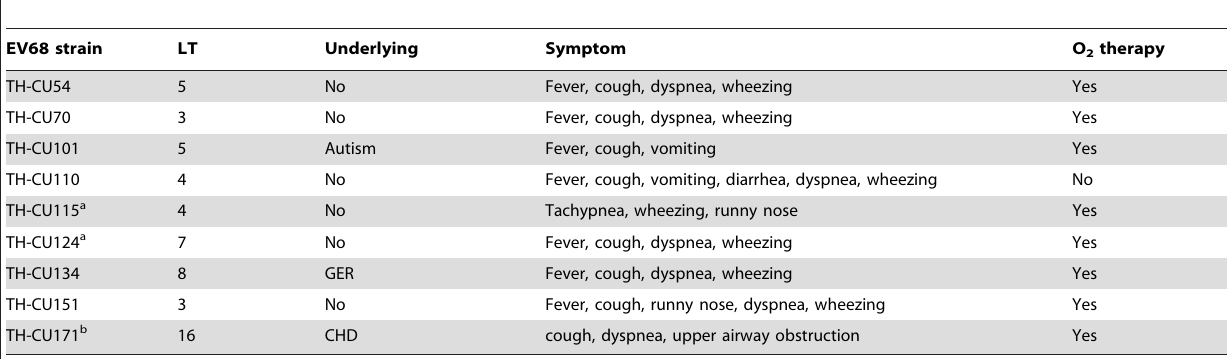
Table 5. Summary of clinical manifestations and diagnoses of the 9 patients hospitalized with EV68 infection.